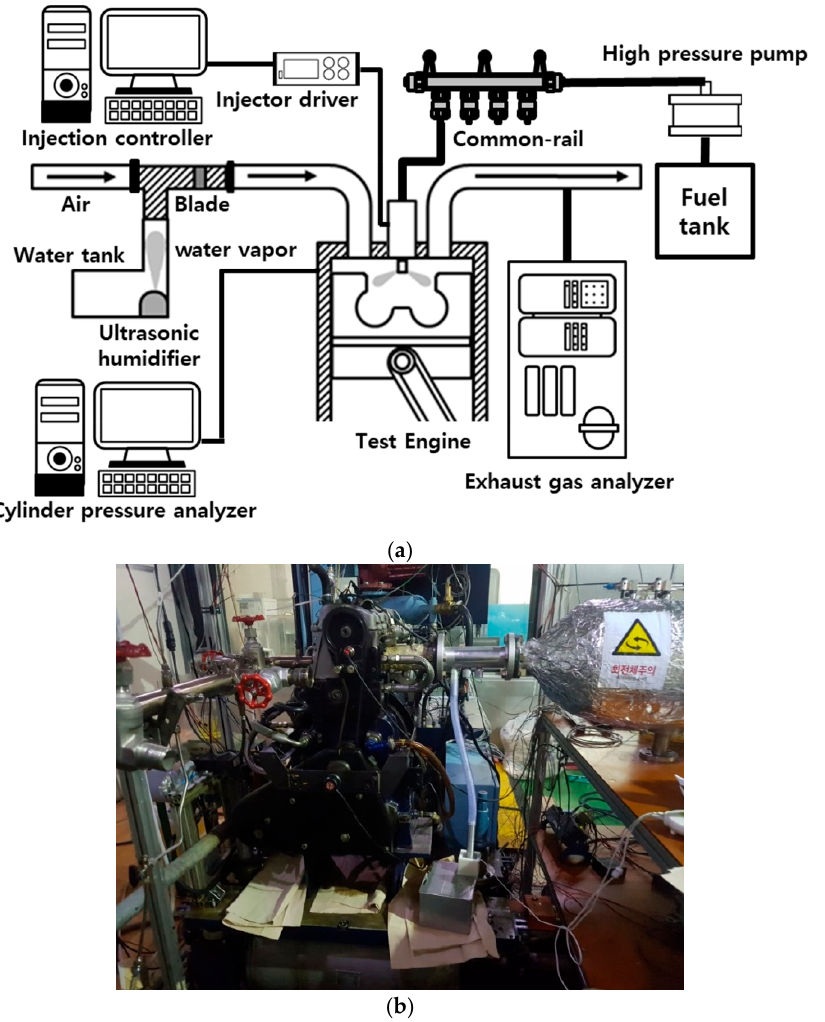
Figure 1. Test engine with water vapor injection system. ( a ) Schematic of experimental setup and ( b ) experimental apparatus.